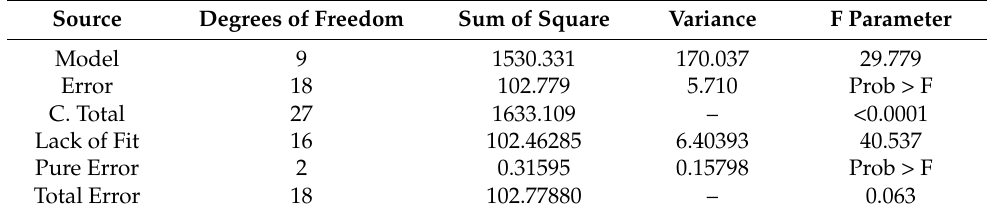
Table 6. ANOVA and lack of fit